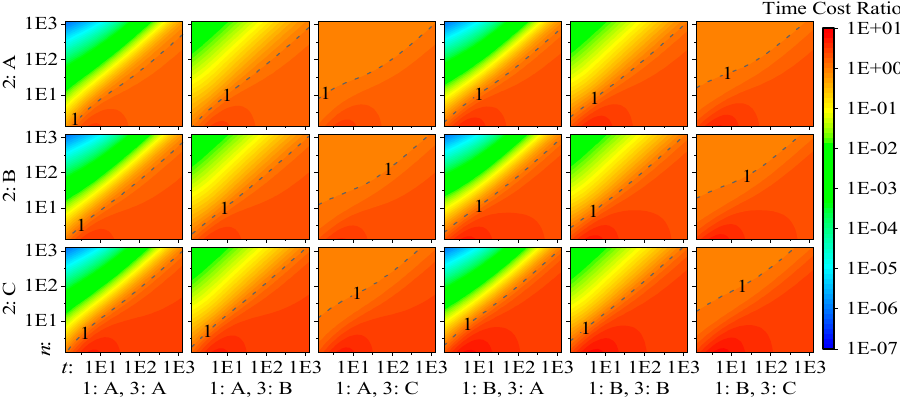
t Figure 2. Computational cost ratio t IF / t KF IF KF